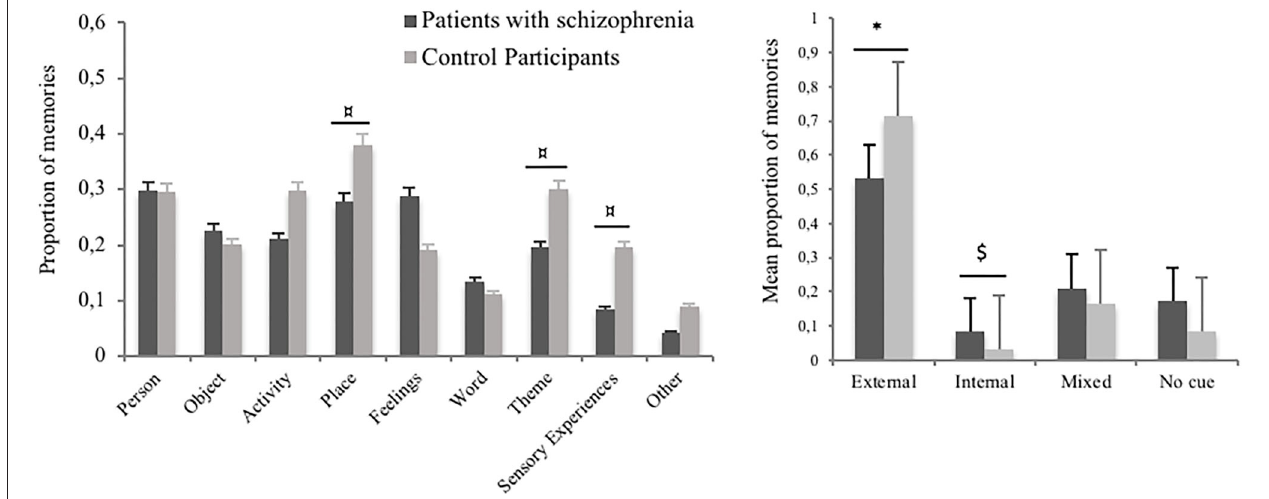
FIGURE 1 | The left plot shows the proportion of involuntary autobiographical memories triggered by each cue category in patients with schizophrenia and in control participants, in Study 1. The right plot shows the proportion of involuntary autobiographical memories triggered by only external cues, only internal cues, mixed cues, or unidentified cues, in Study 1. $ p < 0.15; ¤ p < 0.10; * p < 0.05.